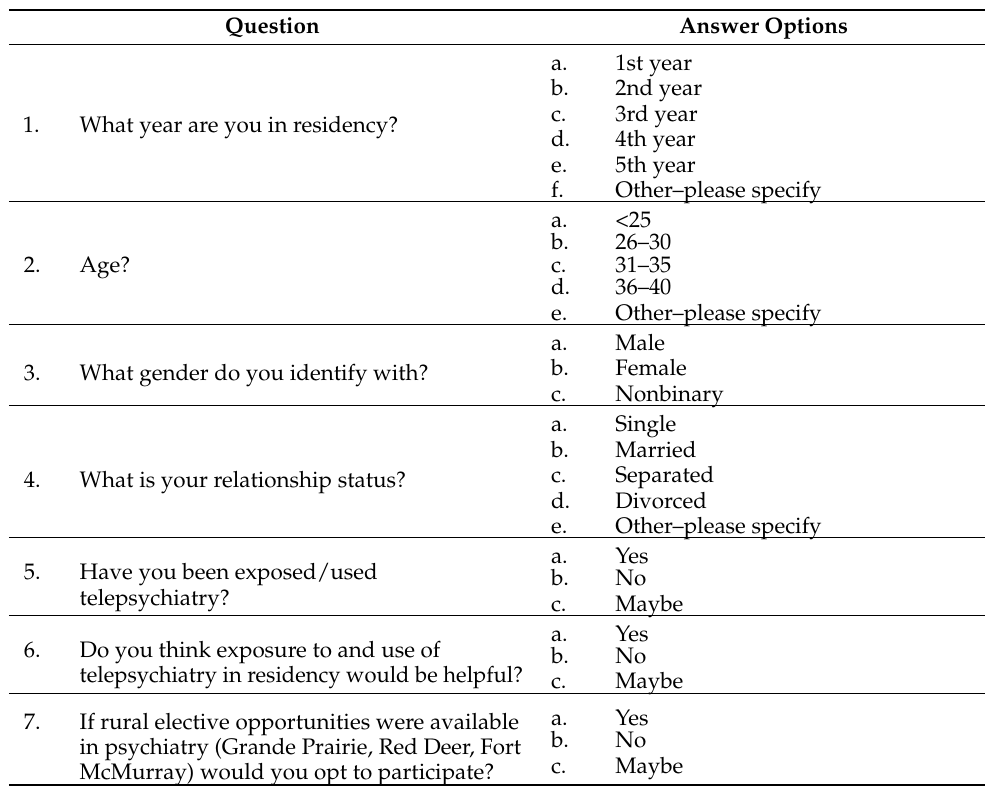
Table A1. Resident Survey on Rural Health Experiences and Future Rural